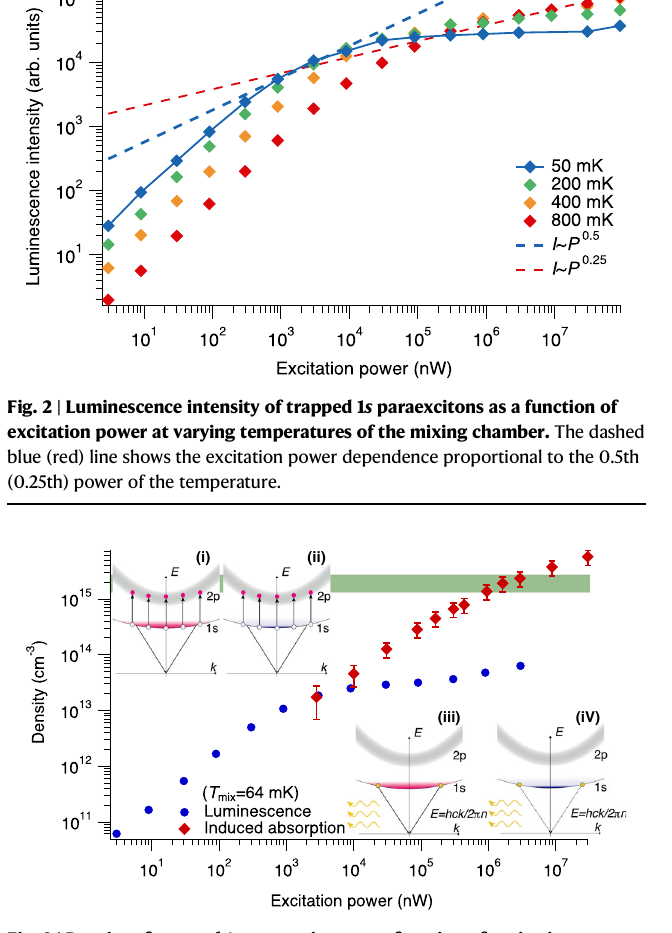
of the signal is 8.0 ± 1.4 μ m (7.8 ± 1.3 μ m) along the [011] ([100]) crystal axis at P pump = 1.6 mW. These widths are smaller than that of the thermal gas (FWHM) of 39 μ m at 170 mK in the trap potential.